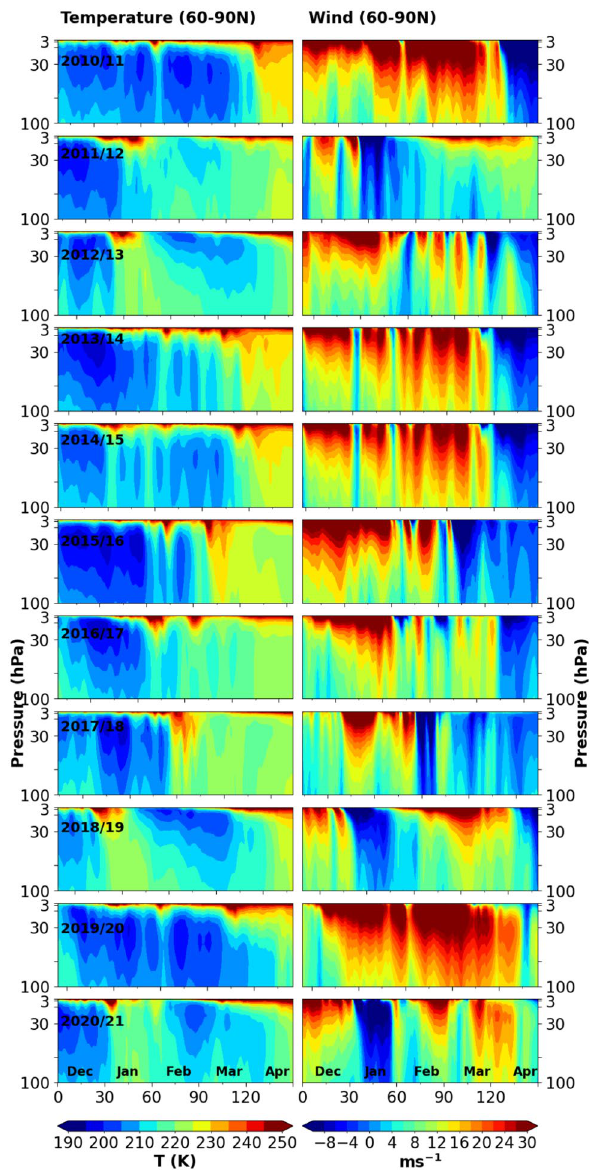
Fig. 2 Temporal evolution of the zonally averaged temperature and zonally averaged wind (60°–90° N) (data: MERRA 2) for the